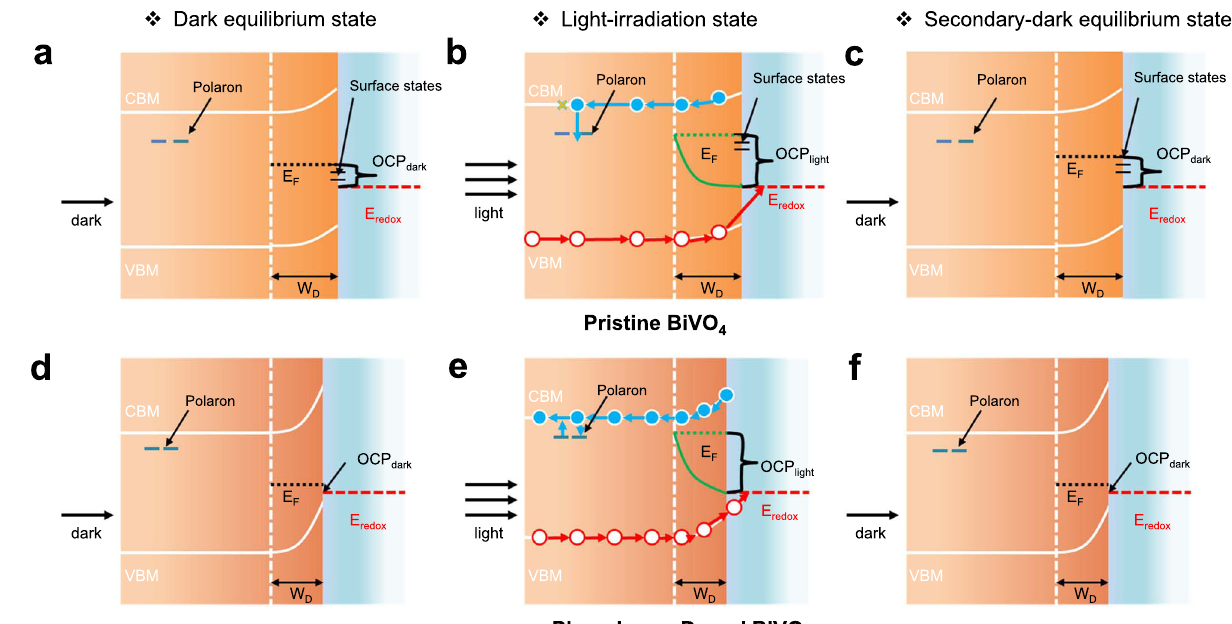
Fig. 8 | Band structures and band bending schematics of the BiVO4 and phosphorus-doped BiVO4 samples. Band structures and band bending sche- matics of the BiVO 4 and phosphorus-doped BiVO 4 samples. a, d Dark equilibrium state, b, e light-irradiation state, and c, f secondary-dark equilibrium state. The relative positions of conduction band minimum (CBM), valence band maximum (VBM), OCP in the dark (OCP dark ), OCP under illumination (OCP light ), depletion